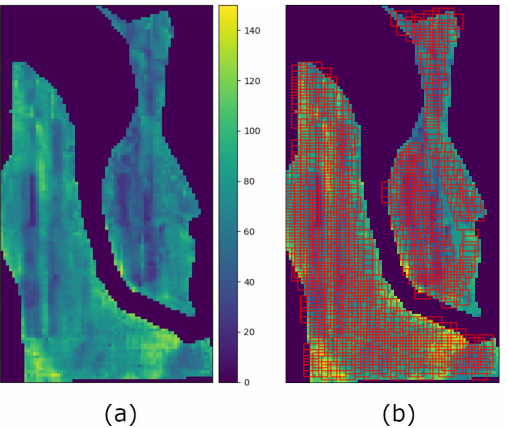
Figure 1. Image rasters corresponding to the G1 field (2018). ( a ) Yield raster. ( b ) Automatic extraction of 5 × 5 pixel